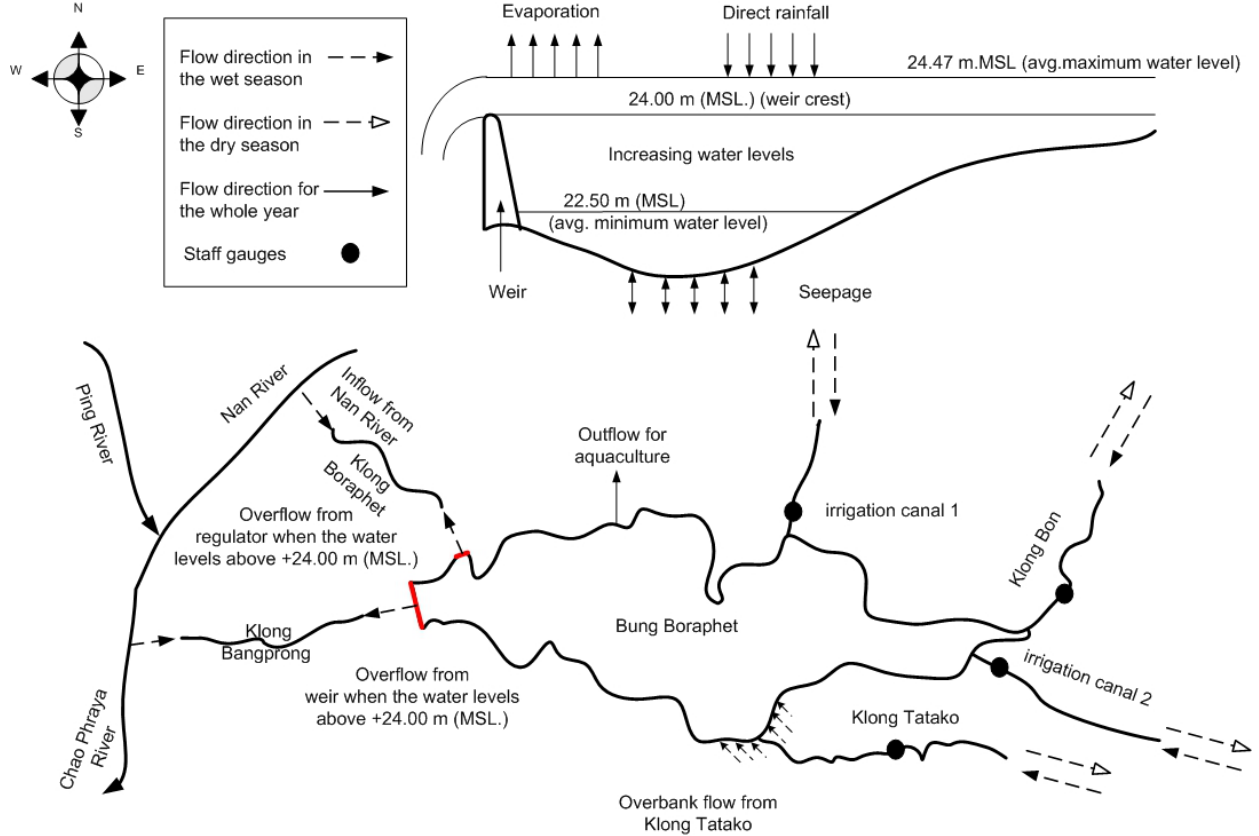
Figure 2. Conceptual model of the water budget for Bung